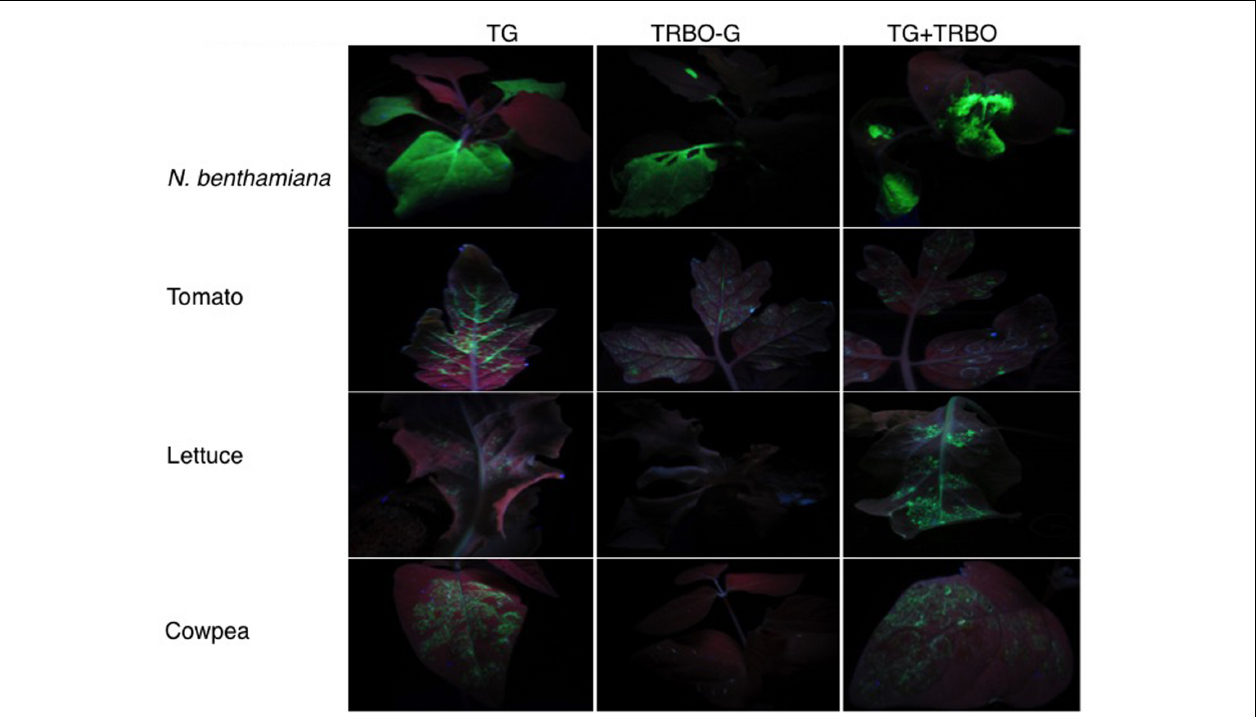
FIGURE 2 | GFP expression upon Agrobacterium mediated infiltration of viral vectors in 4 week-old Nicotiana benthamiana , 3 week-old tomato, 2 week-old lettuce, and 1 week-old cowpea. The constructs used for infiltration are indicated on top. GFP expression was visualized with UV illumination at 3 days post-infiltration (dpi).